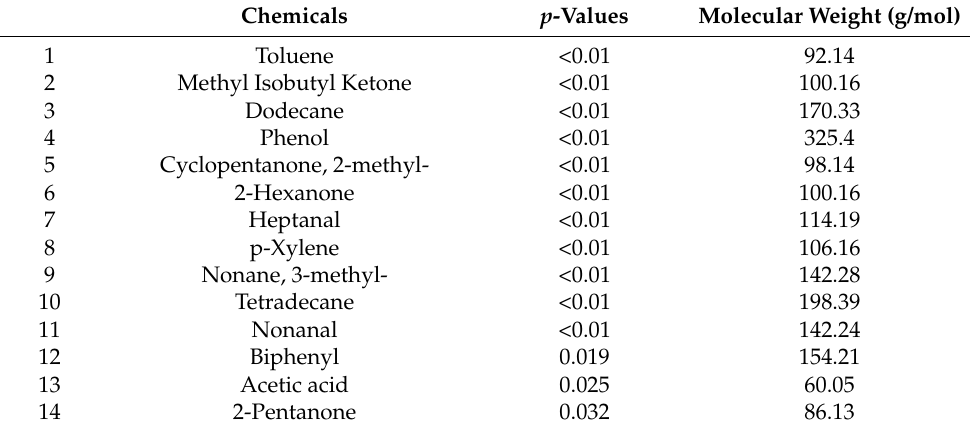
Table 6. List of possible biomarkers from the analysis of urine samples by GC-TOF-MS identified using PubChem, NIST and publications significant to PCa and bladder